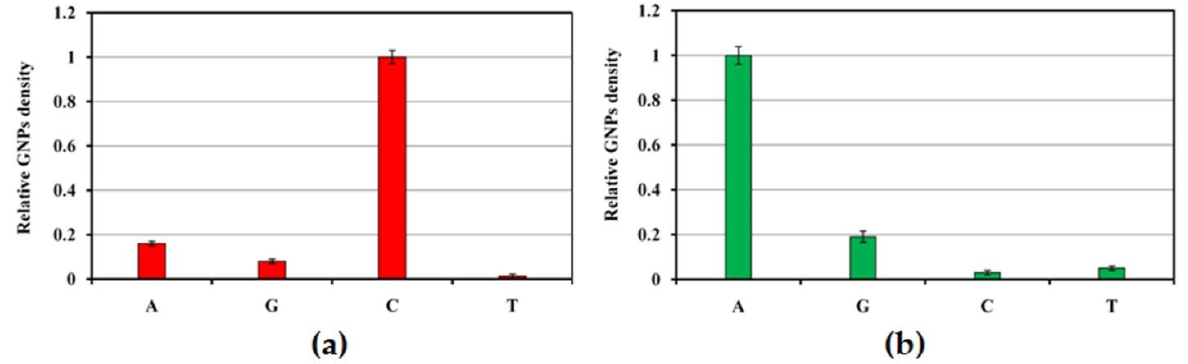
Figure 8. Relative GNP density determined after the hybridization of 20 ng blaCTX-M-3 target DNA with the probe sets for identification of SNPs encoding amino acid replacement at position 167 ( a ) and 240 ( b ) in β -lactamases of the CTX-M-1 subcluster. A, G, C, or T indicates a central nucleotide in the probe.